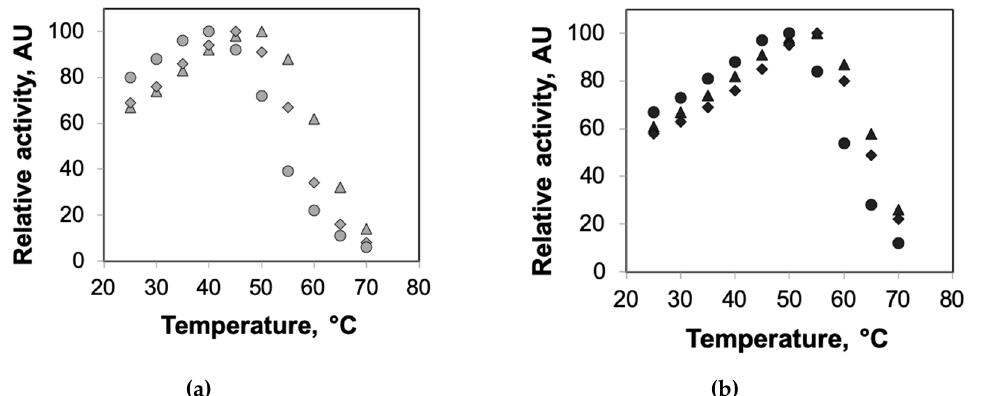
Figure 4. Optimum temperatures of HRP encapsulated in agarose–dextran hybrid gels. The enzyme activities of HRP encapsulated in agarose (circles) and agarose incorporating 100 mg/mL (diamonds) and 200 mg/mL (triangles) dextran—( a ) 0.5% agarose (gray markers) and ( b ) 2% agarose (black markers)—were measured at different temperatures ranging from 25 °C to 70 °C. Each data point represents an average of triplicate measurements, with standard deviation <15%. Table 2. Percent increase in half-lives of enzymes encapsulated in agarose–dextran a hybrid gels (prepared using low-molecular-weight dextran) relative to solution-phase